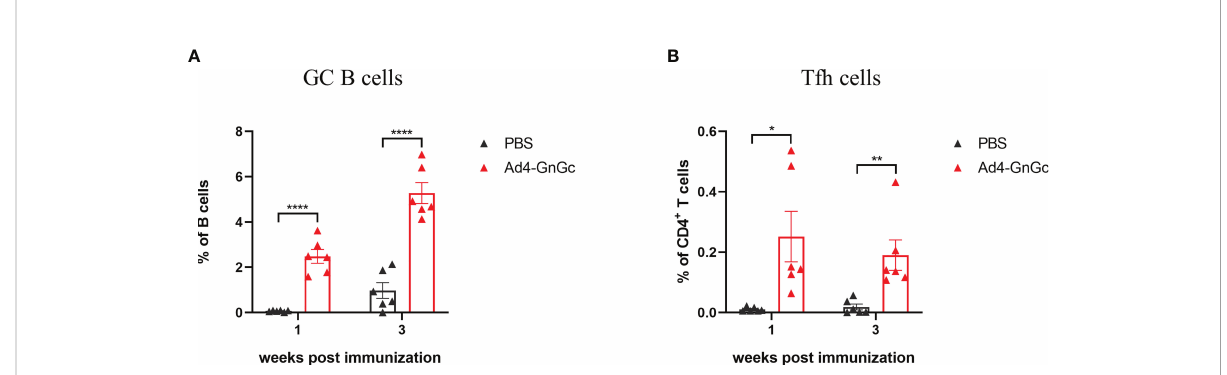
FIGURE 4 Ad4-GnGc vaccine elicits strong GC B cell and Tfh cell responses. BALB/c mice (n = 12) were immunized with a single dose of 10 8 IFU of Ad4- GnGc or PBS via intramuscular route. Half of the mice in each group were sacri fi ced 1 week after immunization, and the other half were sacri fi ced 3 weeks after immunization. The inguinal lymph nodes were collected. (A) The proportion of GC B cells, de fi ned as live CD3 - CD19 + GL7 + Fas + cells, was determined by fl ow cytometry. (B) The frequency of Tfh cells, de fi ned as live CD3 + CD4 + PD-1 + CXCR5 + cells, was measured in each group. Data are displayed as the mean ± SEM. P values were analyzed with an unpaired Student ’ s t test. * P < 0.05, ** P < 0.01, **** P <